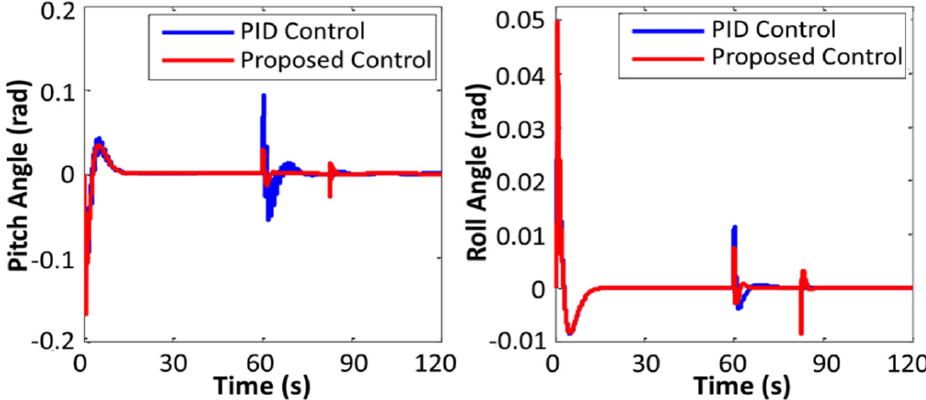
Figure 10. Performance of the quadcopter in tracking the desired Roll and Pitch angles. Variations in the values of the manipulated variables u 1 , u 2 , u 3 and u 4 are plotted in Figures 11 and 12. Figures 13 and 14 exhibit changes in control gain values that occurred during the operation of the